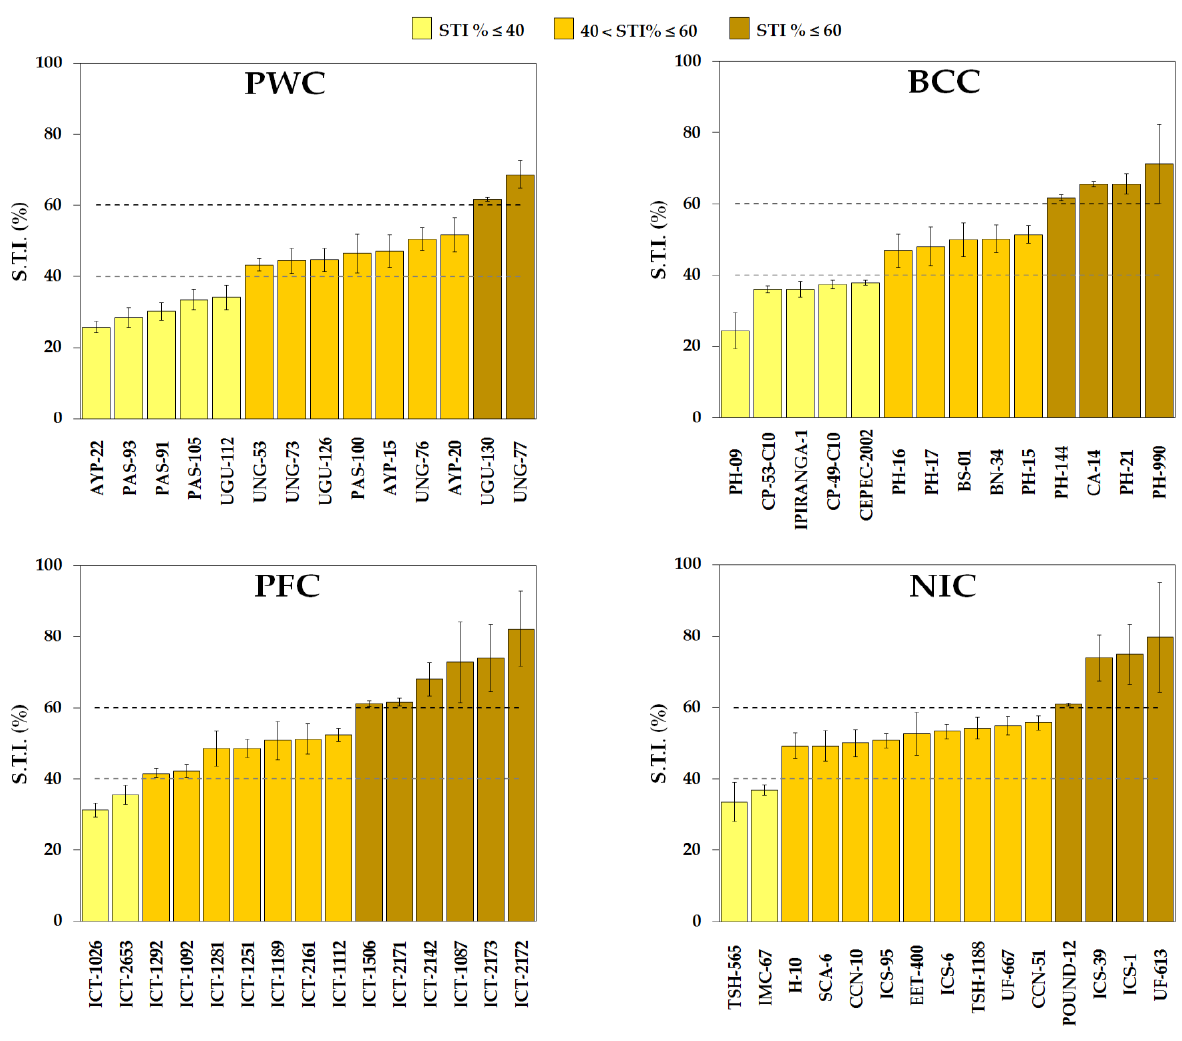
Figure 4. Shade tolerance index (STI, ± SD) of 58 cacao genotypes subjected to two levels of shade (40%, 80%). PWC: wild cacao (from river basins of Peruvian Amazon) [ n = 14]; PFC: Peruvian farmers’ cacao [ n = 15]; BCC: Brazilian cacao [ n = 14]; NIC: national and international cacao collections [ n = 15]. Genotypes were classified into three groups: sensitive to shade (STI% ≤ 40), medium shade-tolerant (40 < STI% ≤ 60) and tolerant to shade (STI% > 60).